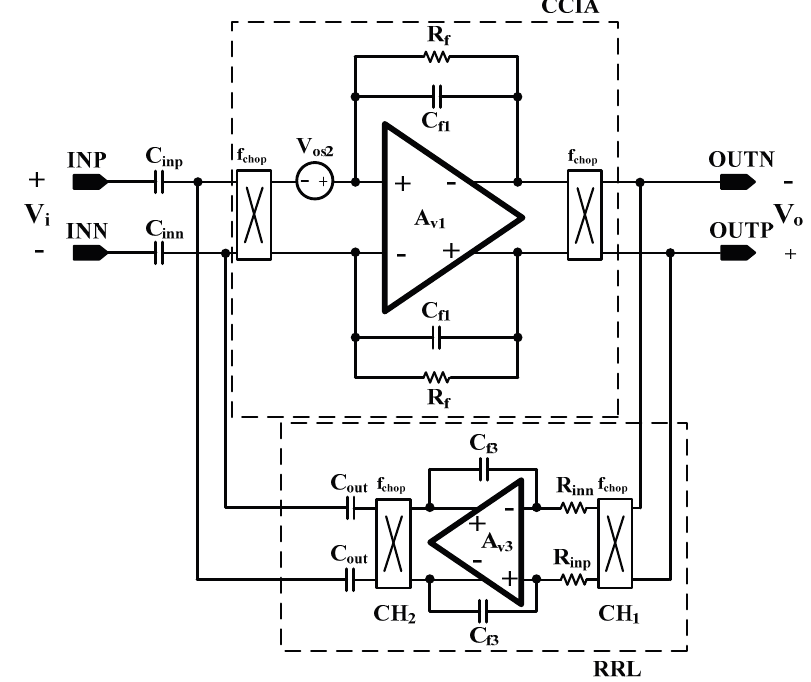
Figure 10. Schematic of the